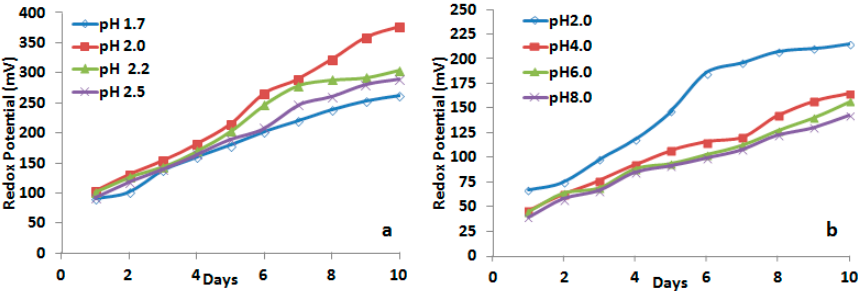
Figure 3. Variation in redox potential during leaching of PCB at different pH values, 308 K using <150 µm particles [( a ) bacterial leaching; ( b ) fungal leaching].